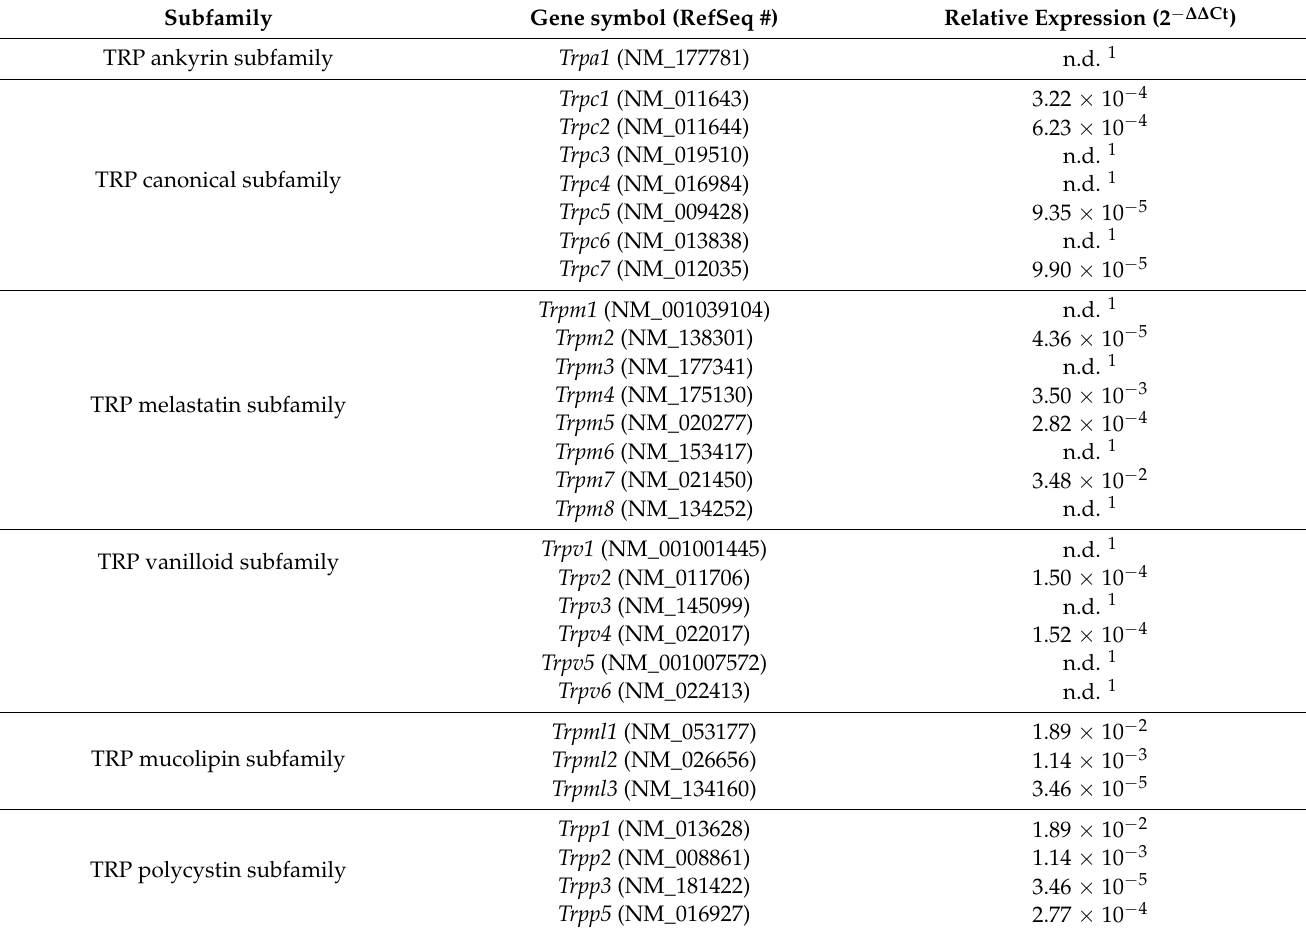
Table 1. TRP gene expression levels in mouse